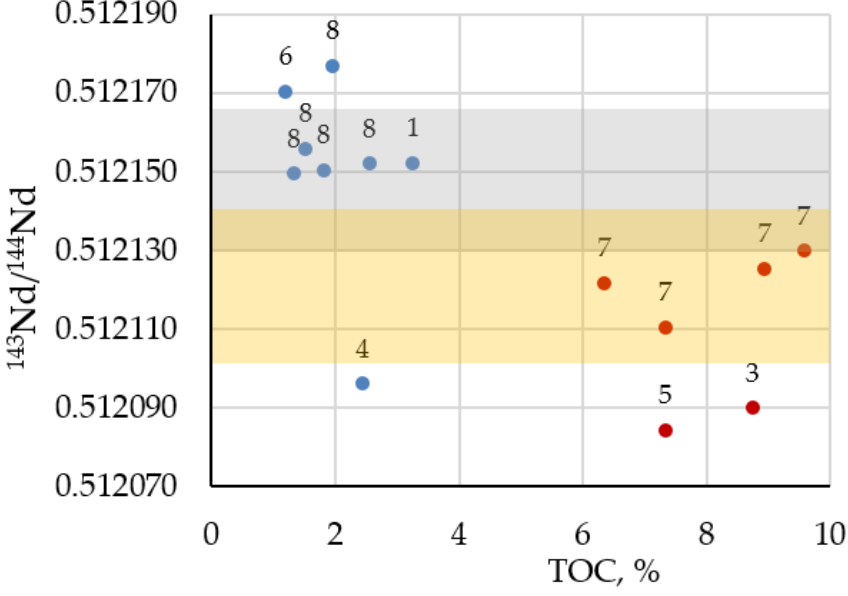
Figure 5. Nd isotope ratio vs. TOC plot. The characteristic values of 143 Nd/ 144 Nd ratios are given by shaded areas for weathering crust of Siberian Craton (grey) and Urals (yellow) (corrected for the time of the Bazhenov Formation sedimentation).